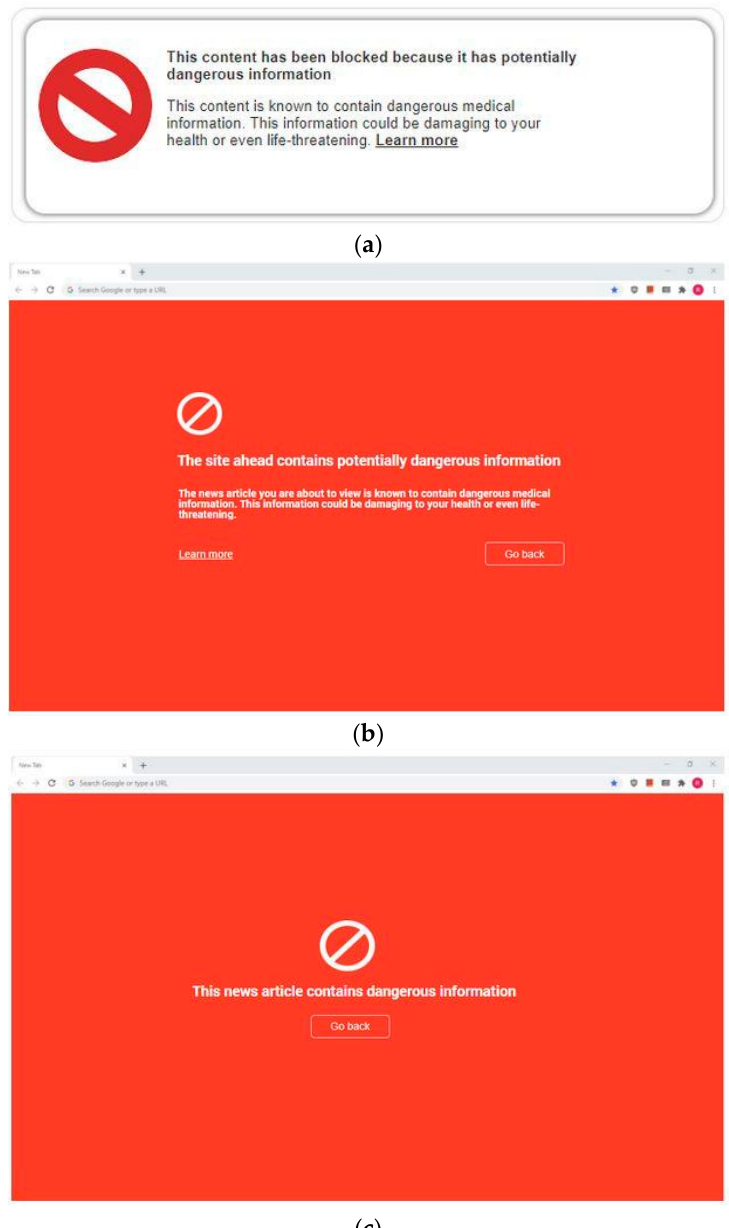
Figure 15. Examples of blocking: ( a ) Blocking 1—label with explanation; ( b ) Blocking 2—page with explanation; ( c ) Blocking 3—page without explanation.